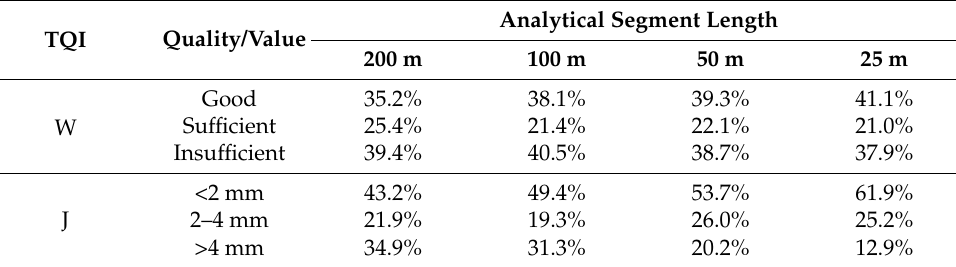
Table 6. Shares of W and J indices values calculated for different analytical segment lengths.